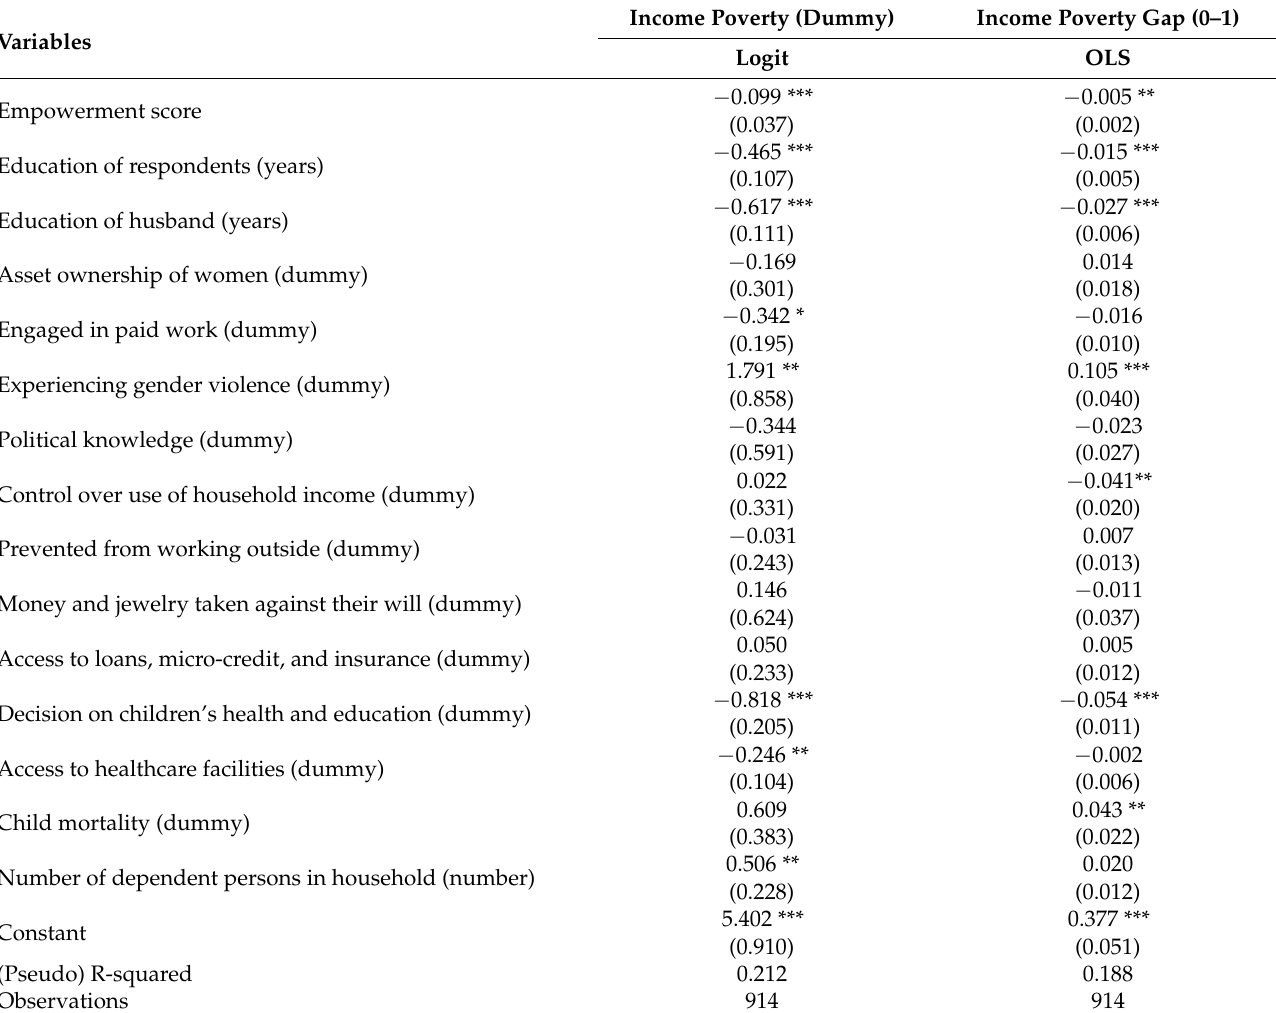
Table 6. Effect of women’s empowerment on income